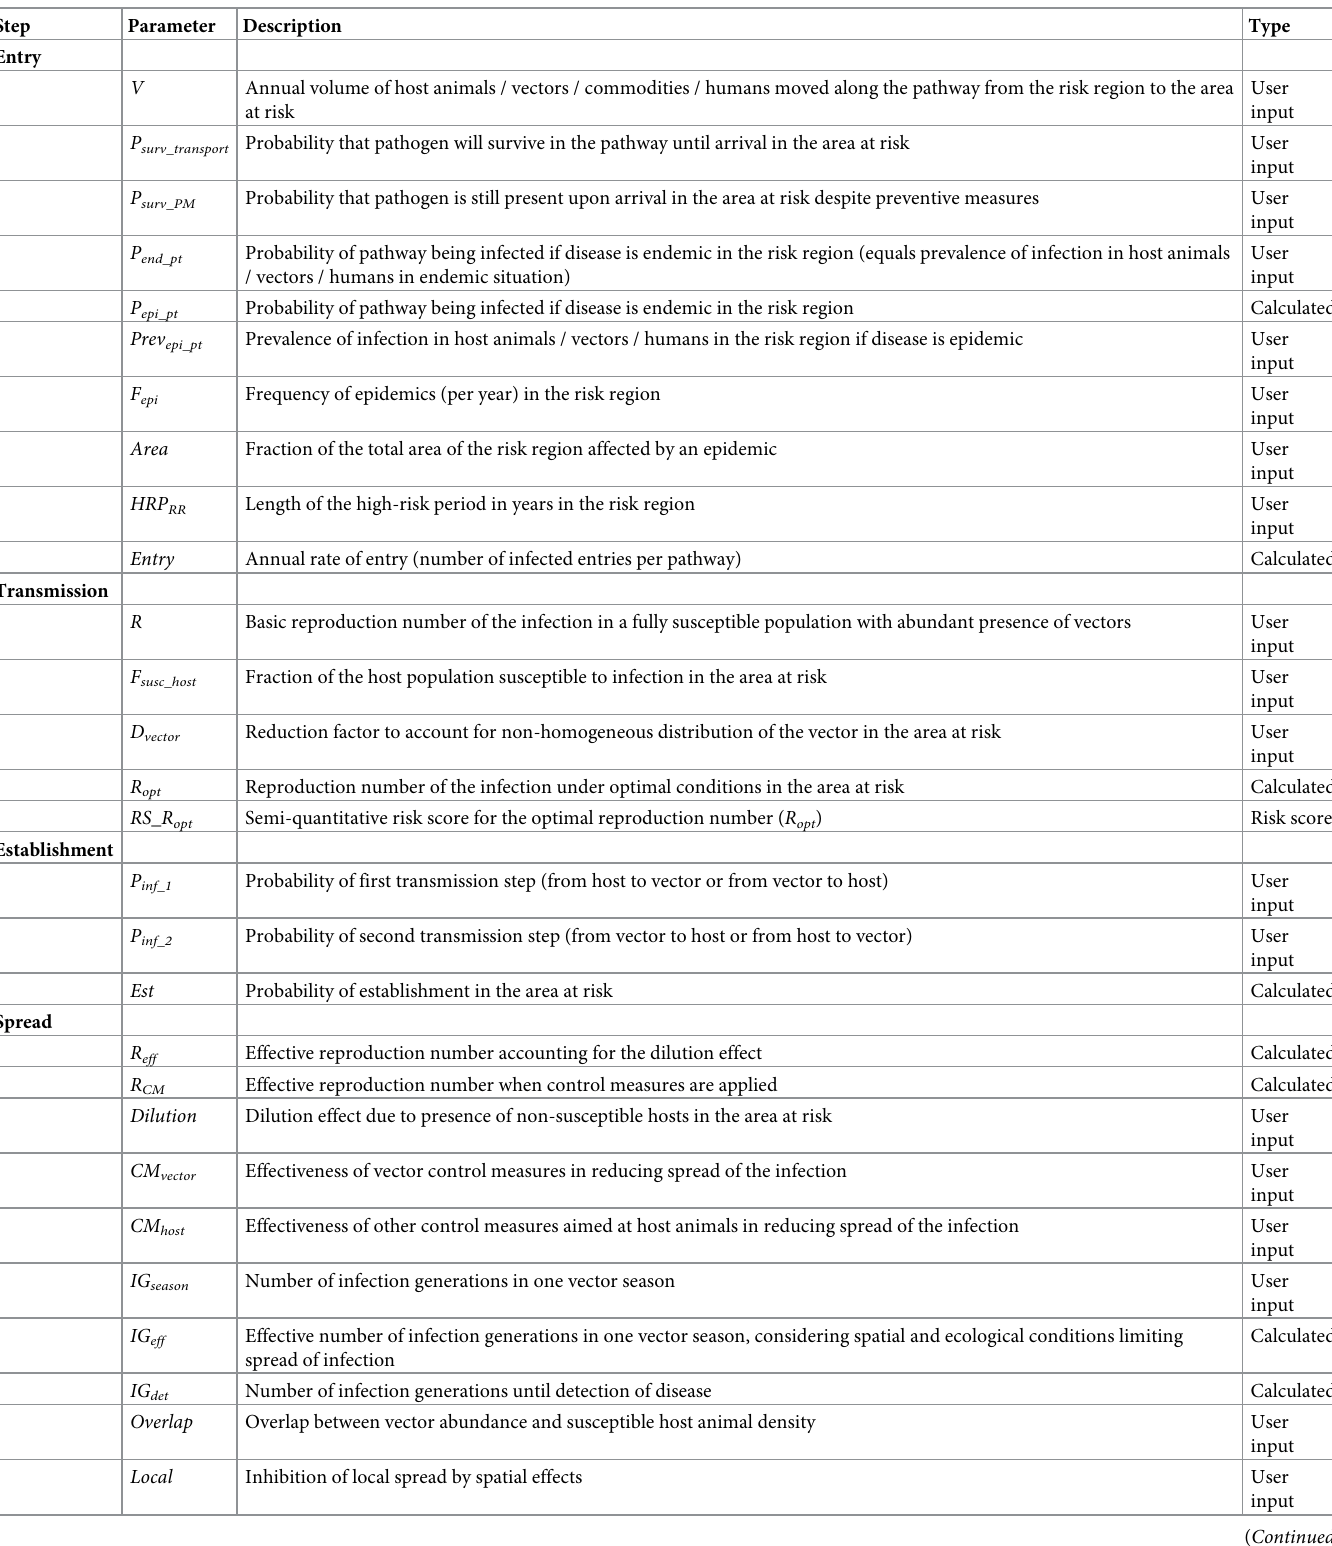
Table 1. List of parameters used for calculations in